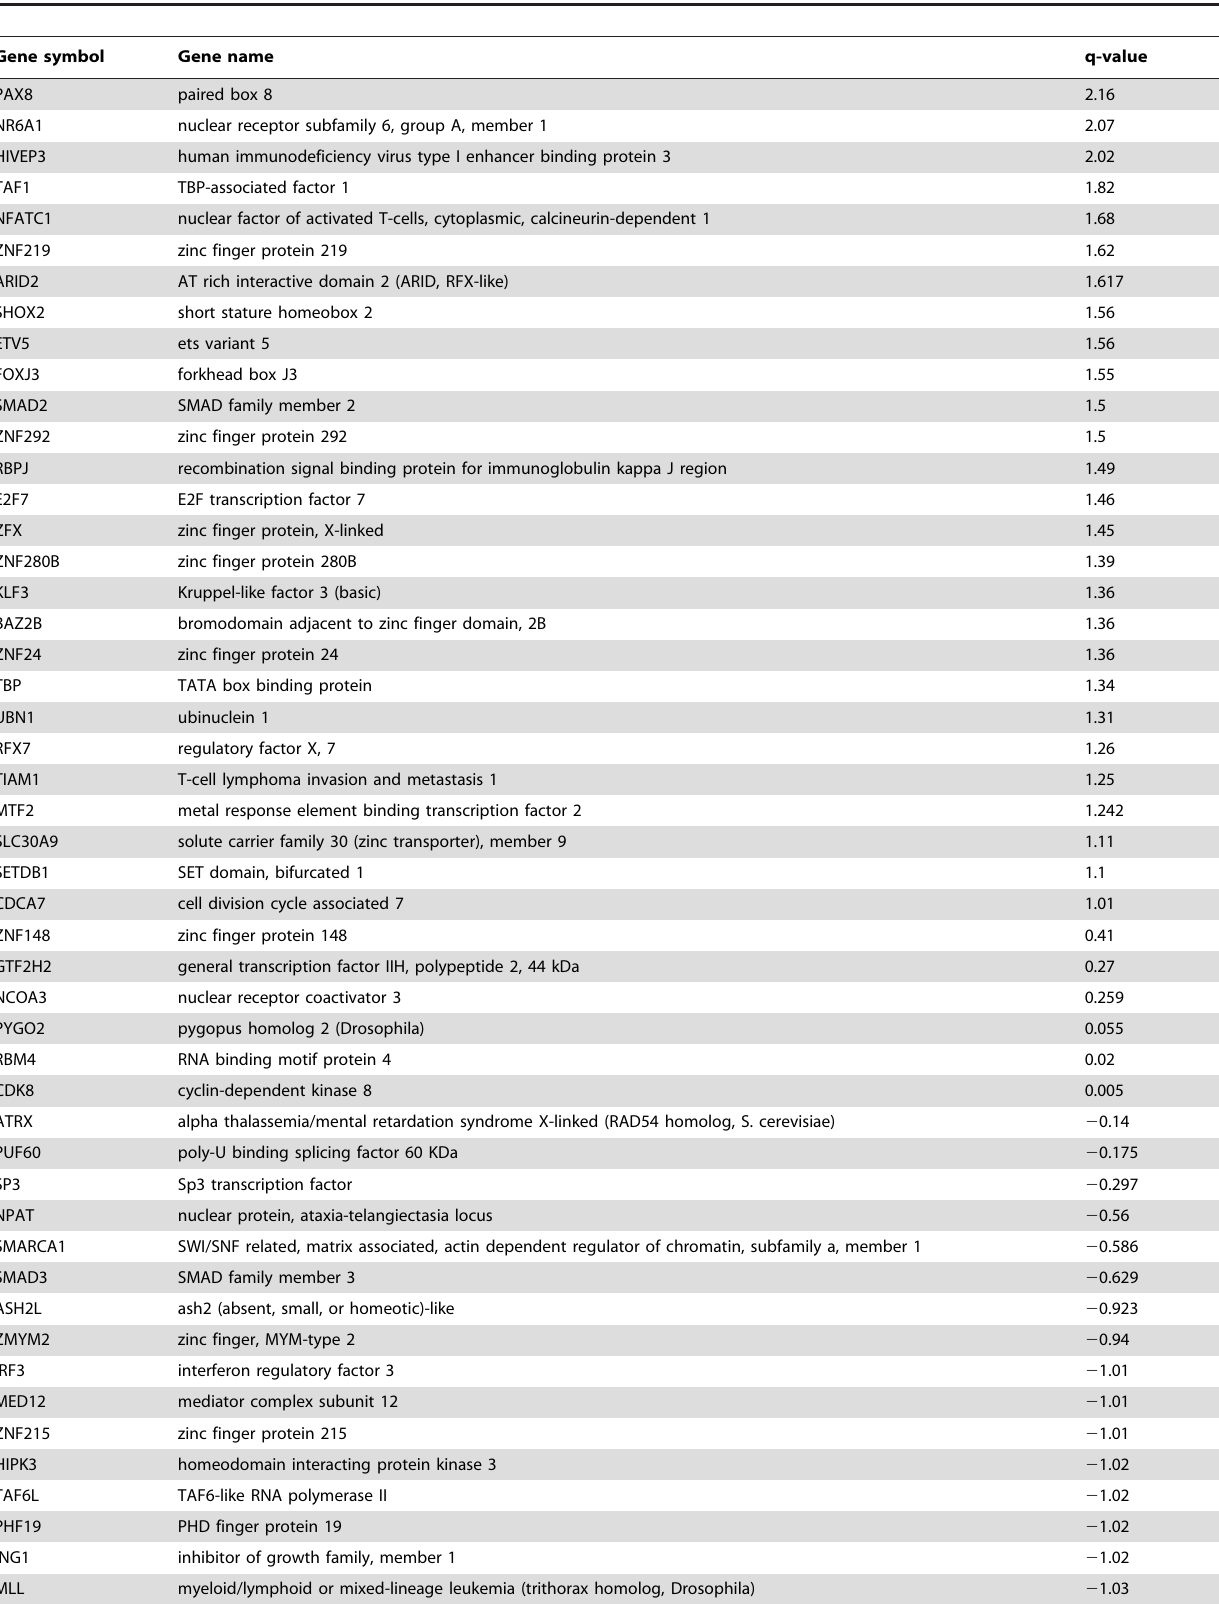
Table 1. Transcription factor expression significantly altered by ESC